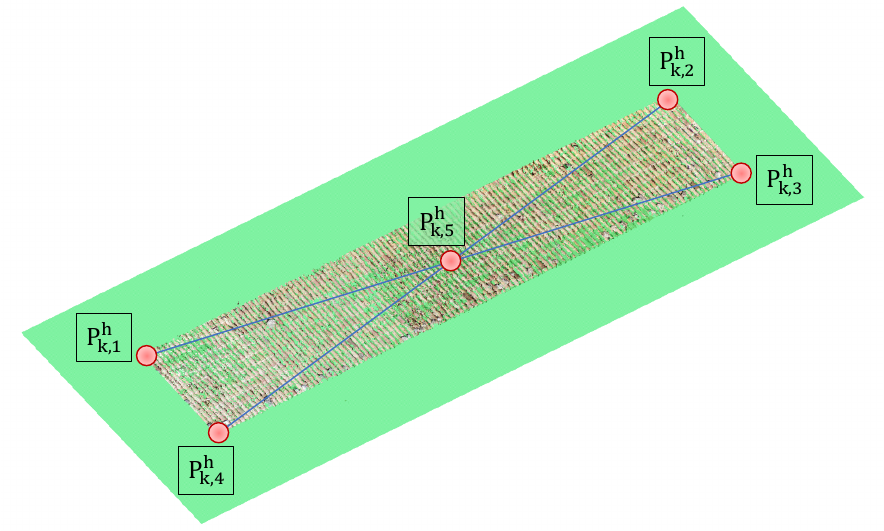
Figure 4. Example of the non-ideal feature with superimposed ideal-features and the reference